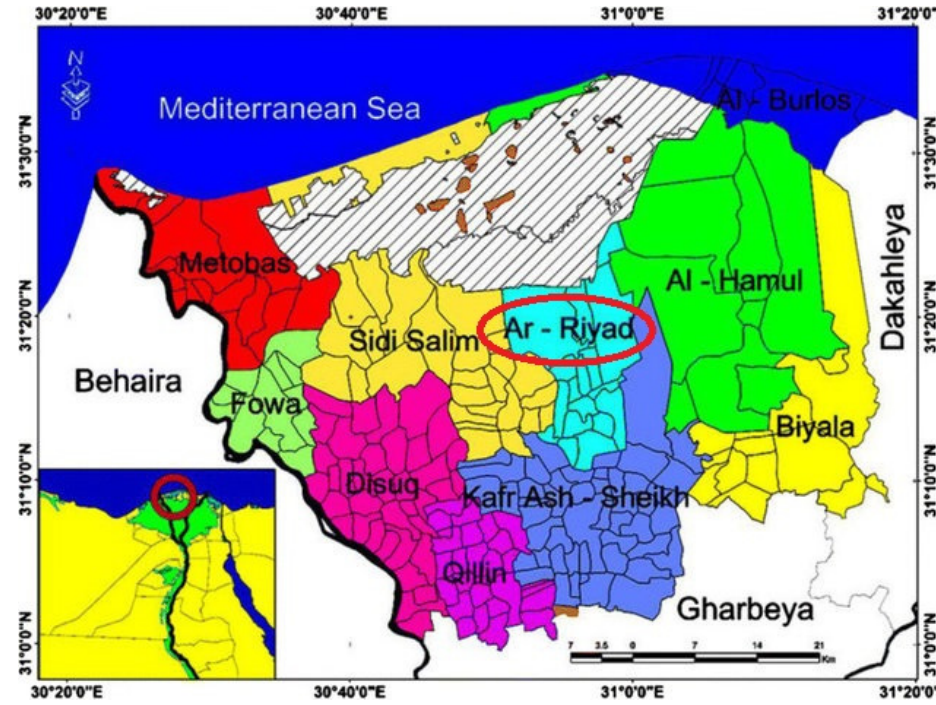
Figure 1. Map of sample collection site, Kom el-Khanzir’s hill.